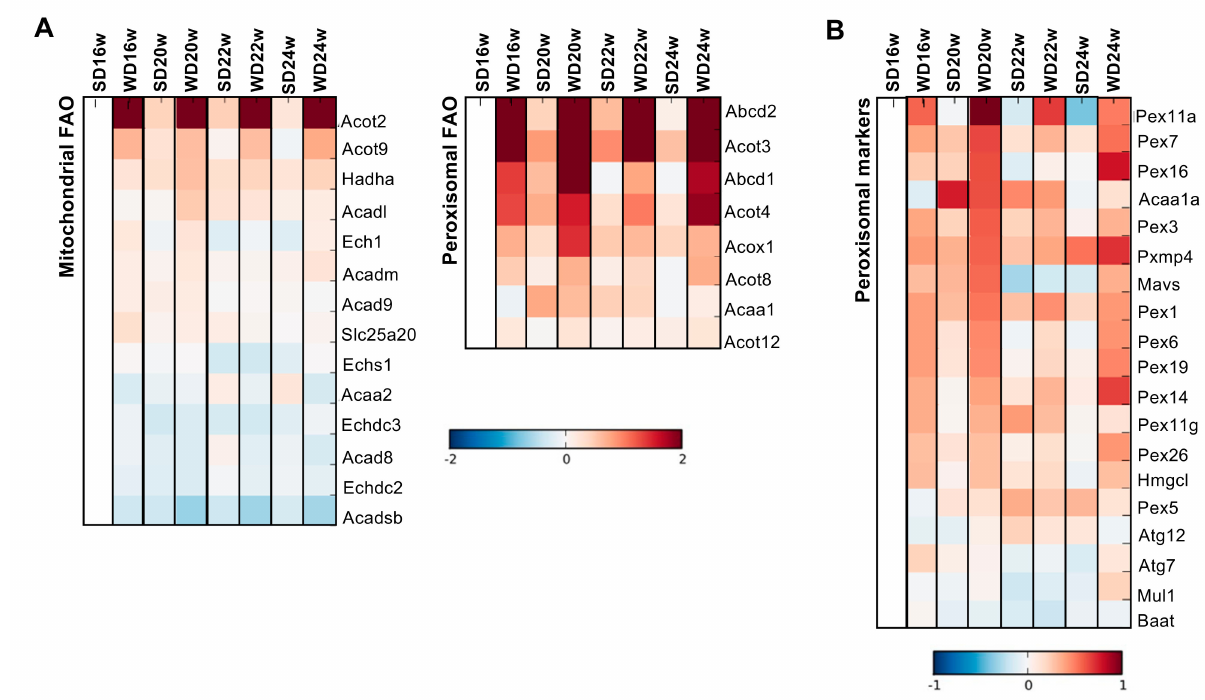
total capacity. ( C ) Mass spectrometry analysis of protein levels involved in the antioxidant defense system. Blue color represents decreased, and red color represents increased levels. ( D ) Principal component analysis (PCA) of oxidative stress-related data. Number of replicates = 3. All data are expressed as the mean ± SEM. (*) vs. SD, (§) vs. 16 w, (&) vs.